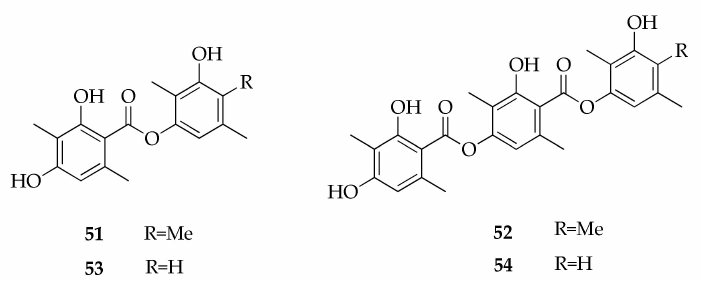
Figure 12. Structures of depsides.